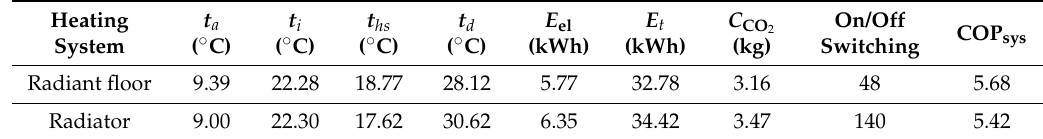
Figure 9. Variation of indoor air temperature. Table 1. Experimental results.